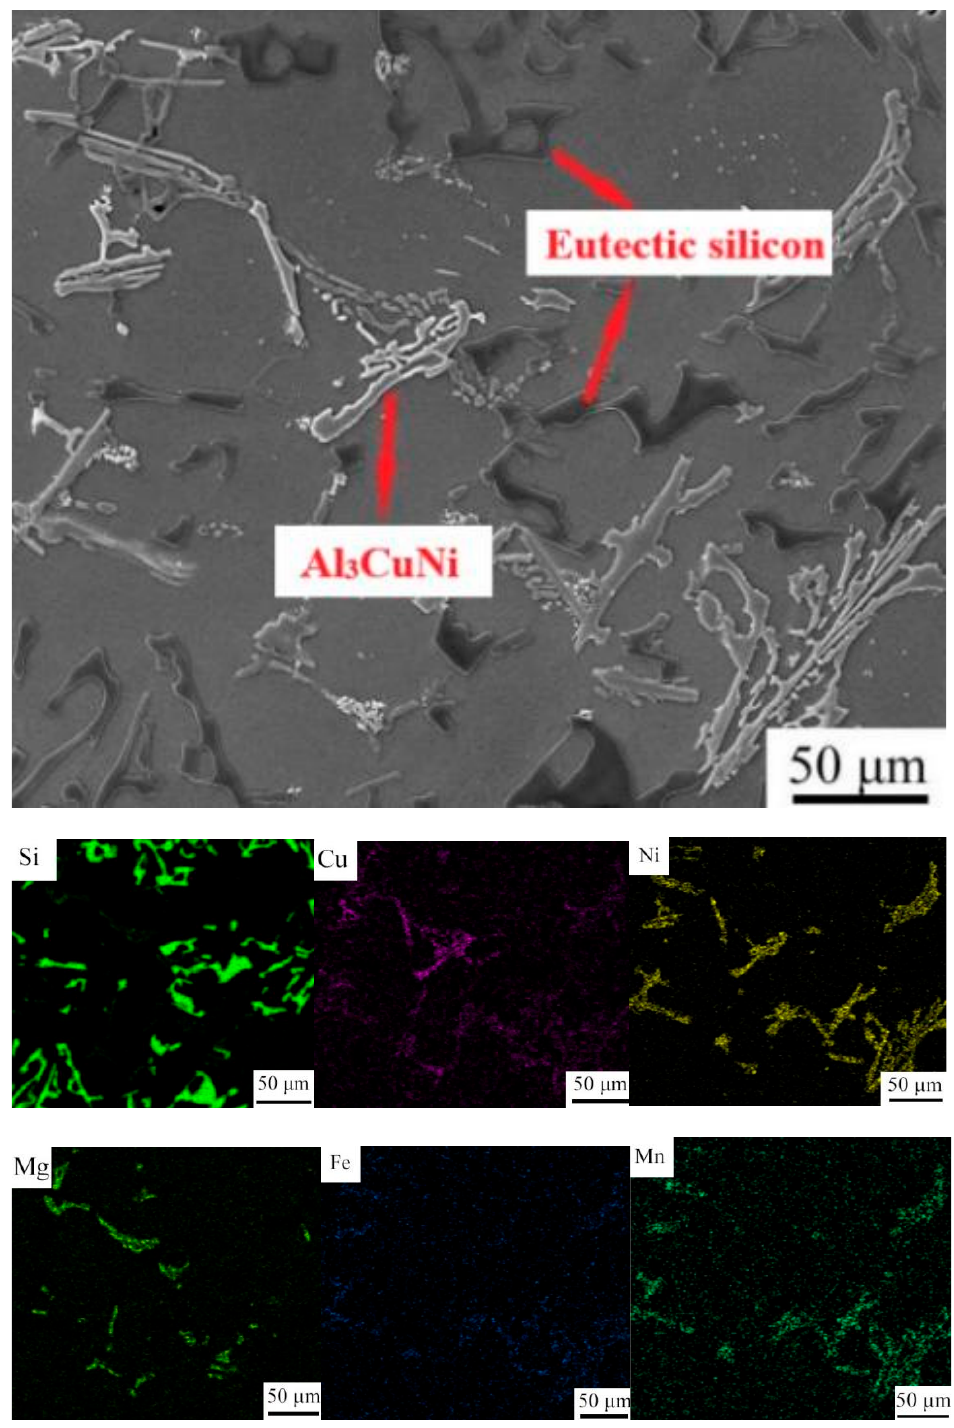
Figure 5. SEM morphology of thermally exposed Al-Si-Cu-Ni-Mg alloy and the distribution of alloy constituent